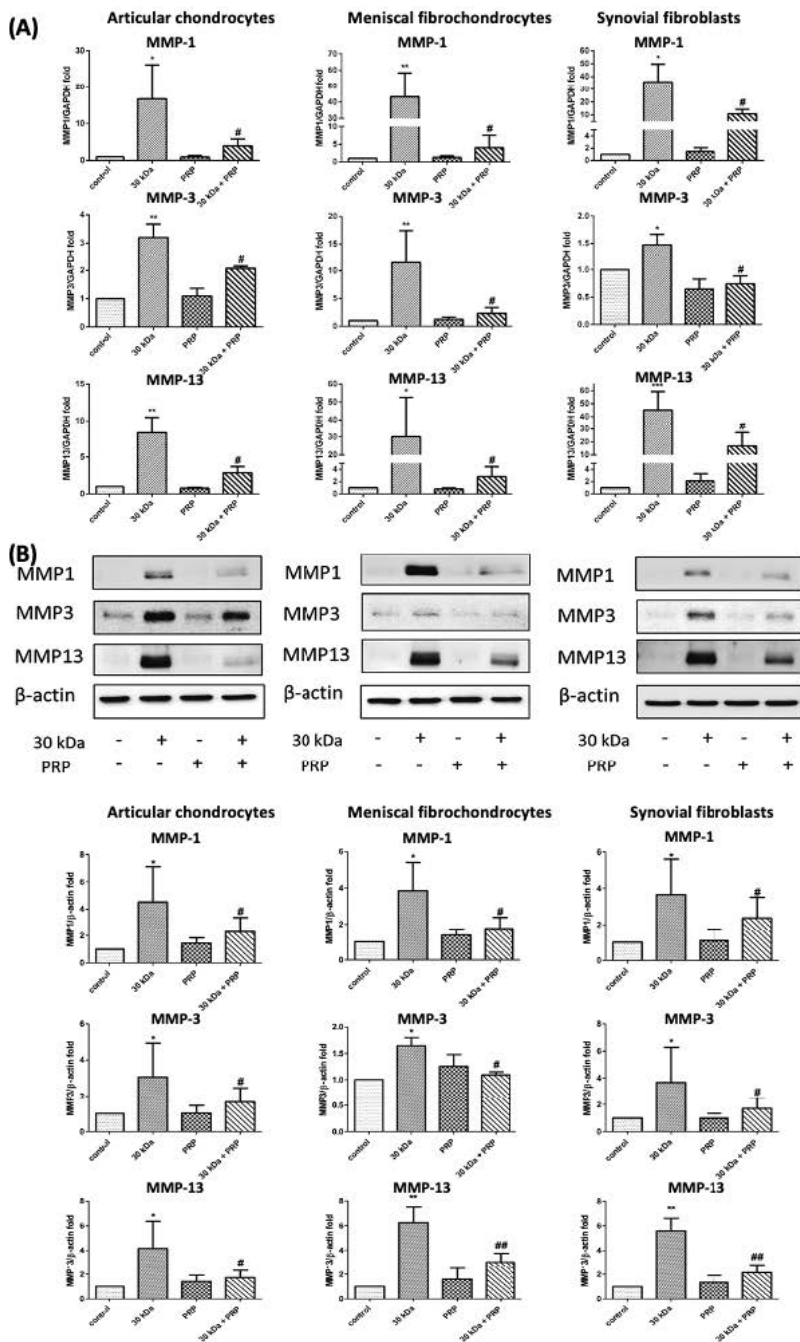
Figure 3. Effects of PRP on 30 kDa FN-f-induced MMP gene and protein expression in articular chondrocytes, meniscal fibrochondrocytes, and synovial fibroblasts. ( A ) Significant suppression of MMP-1, MMP-3, and MMP-13 was observed in all three cell types. (* p < 0.05, compared with control; ** p < 0.01, compared with control; *** p < 0.001, compared with control; # p < 0.05, 30 kDa + PRP vs. 30 kDa; n = 5 for each group). ( B ) Similar responses were observed in protein levels. Representative blots are presented in the upper panel, and semiquantitative data are presented in the lower panel. All data are presented as the mean ± SD. Statistical differences among the TLR groups were compared with control values using the Student’s t -test (* p < 0.05, compared with control; ** p < 0.01, compared with control; # p < 0.05, 30 kDa + PRP vs. 30 kDa: ## p < 0.01, 30 kDa + PRP vs. 30 kDa; n = 5 for each